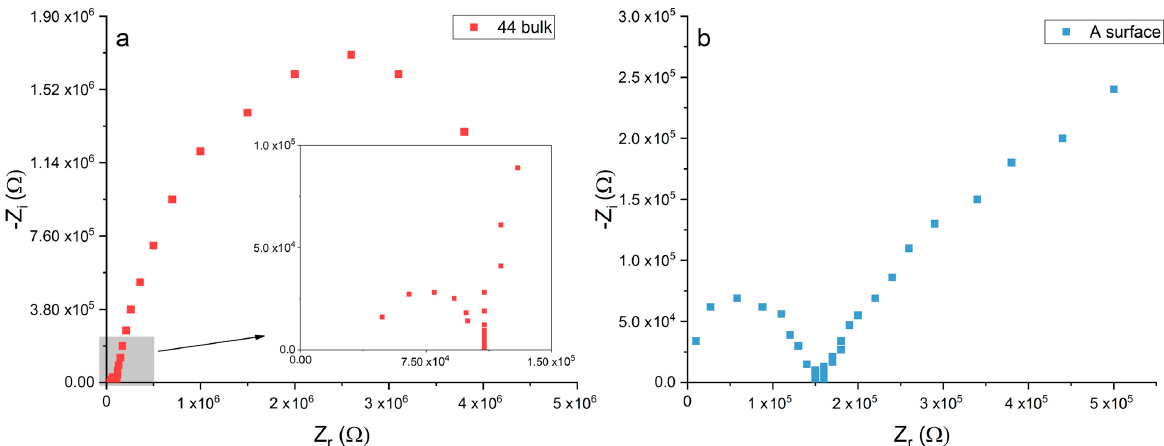
Figure 10. Corrosion potential (E corr ) measured on surfaces of the San Carlone with a Ag/AgCl reference electrode. ( a ) E corr measurements on the surfaces and the polished cross-sections of iron fragments; ( b ) on-site E corr measurements on adjacent copper and iron surfaces.